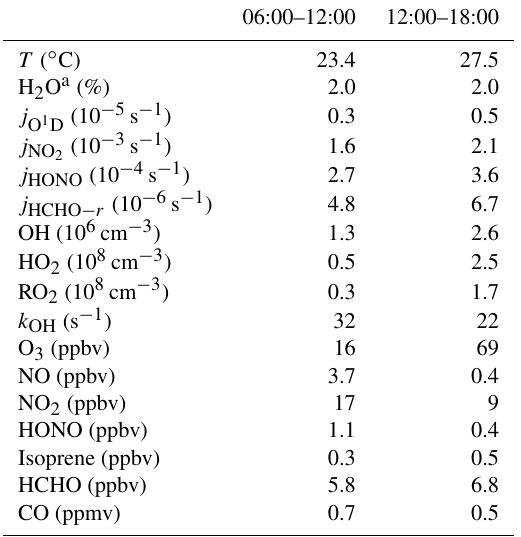
Table 2. Median values of measured parameters in the morning and